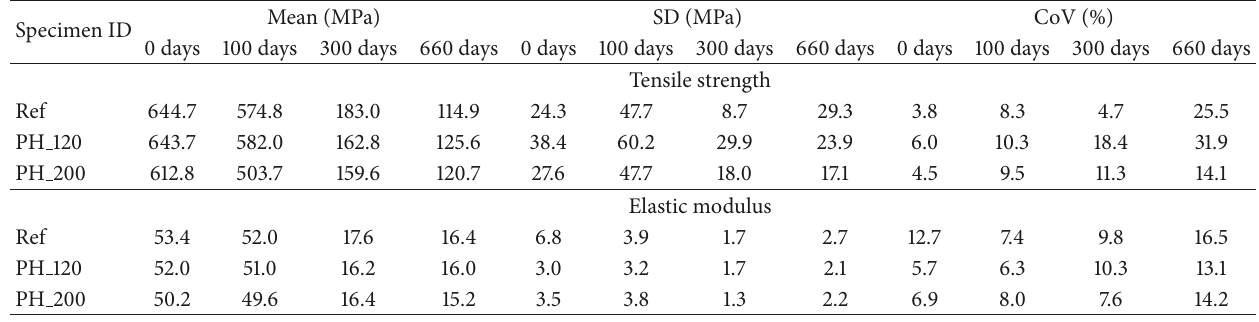
Table 2: Tensile strength and elastic modulus.